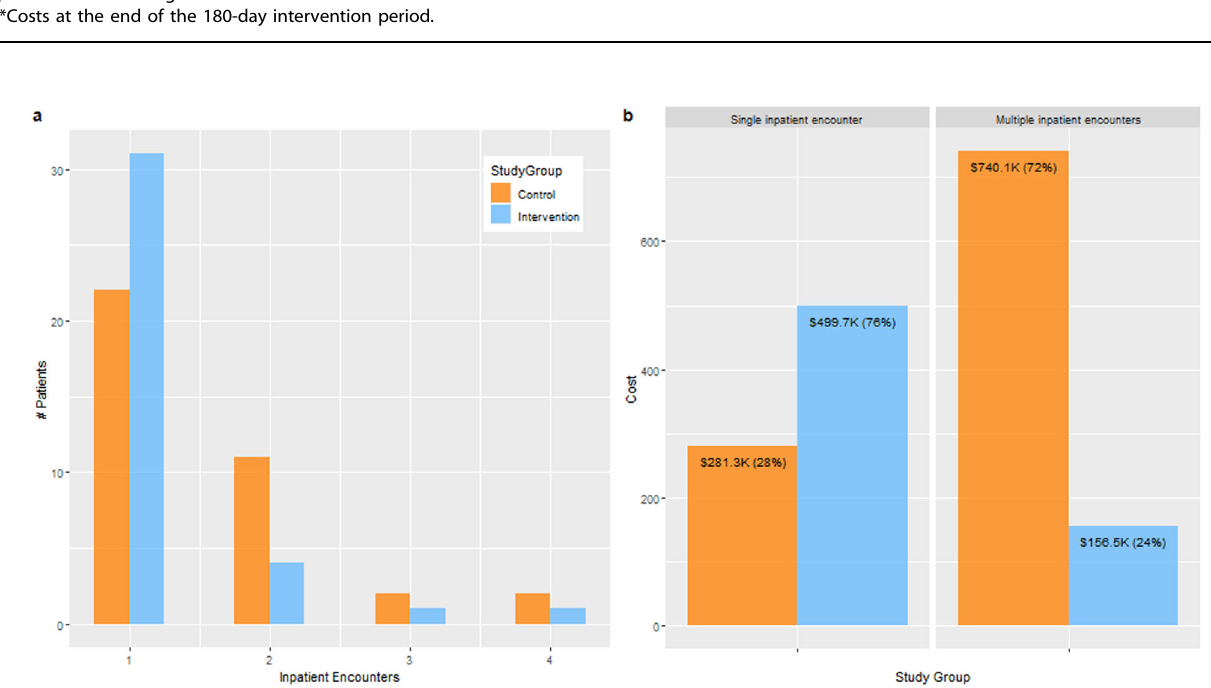
Fig. 4 Patients with single vs. multiple inpatient encounters and their costs. Summarizes between-groups differences in ( a ) patients with single and multiple inpatient encounters and ( b ) associated